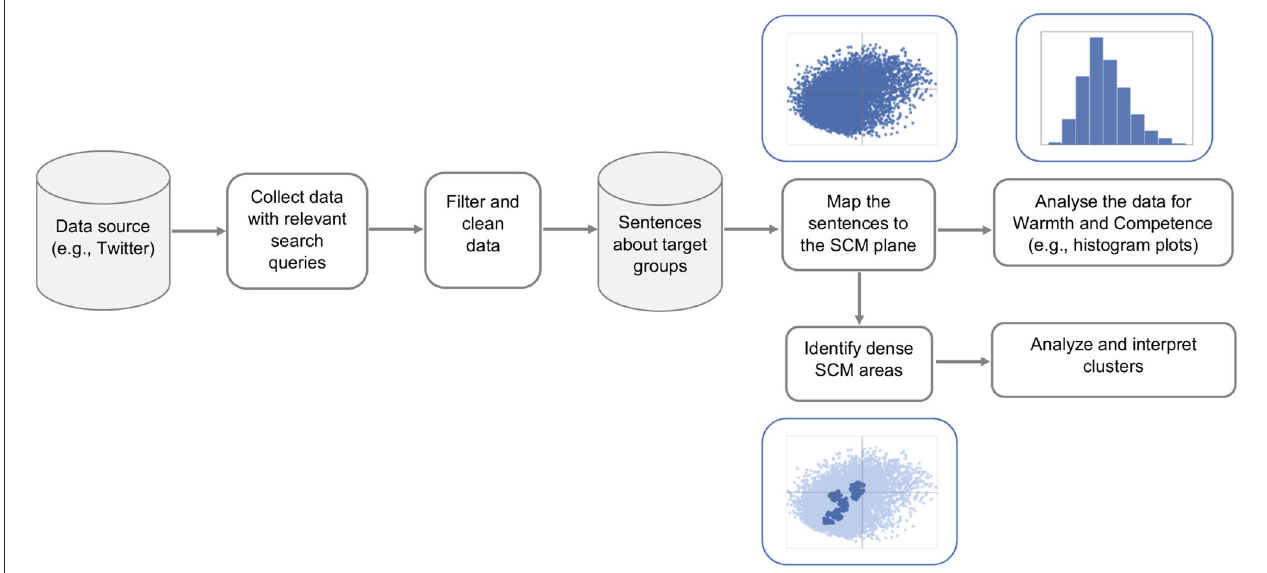
FIGURE 2 | Analyzing stereotypical language “in-the-wild”: steps for collecting, filtering, and analyzing real-life data about social